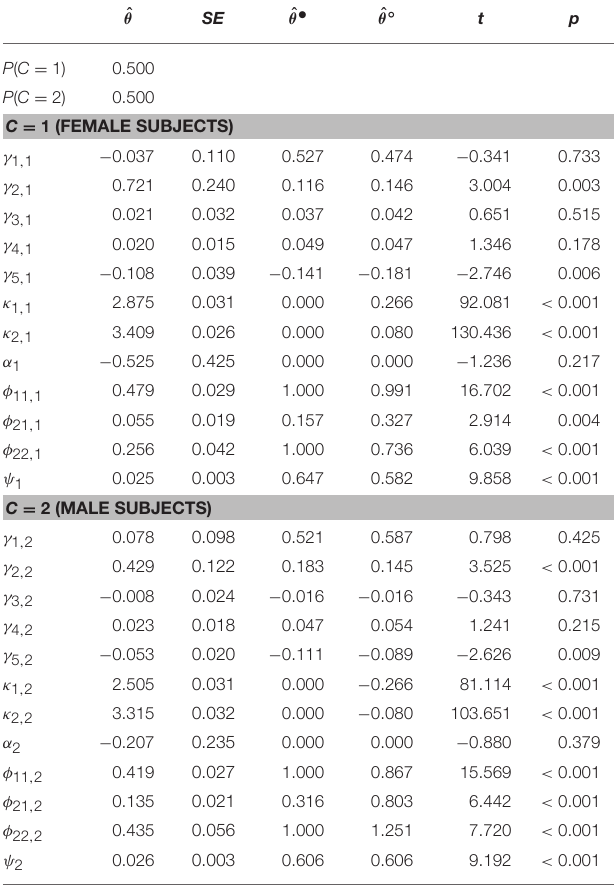
TABLE 4 | Unstandardized and standardized parameter estimates, standard errors, t - and p -values for the direct application of a nonlinear model with two observed classes